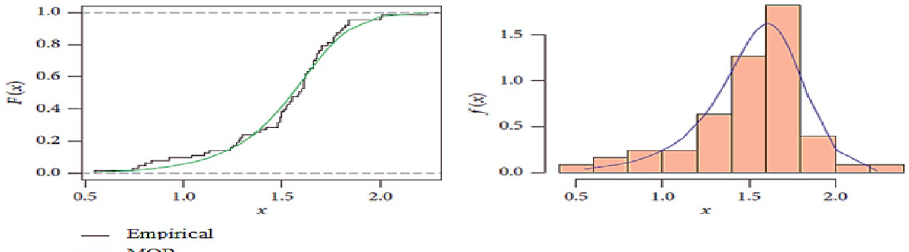
Fig 3. Plot of the max K–S distance between two empirical CDF, and histogram of MOP distribution for data set.